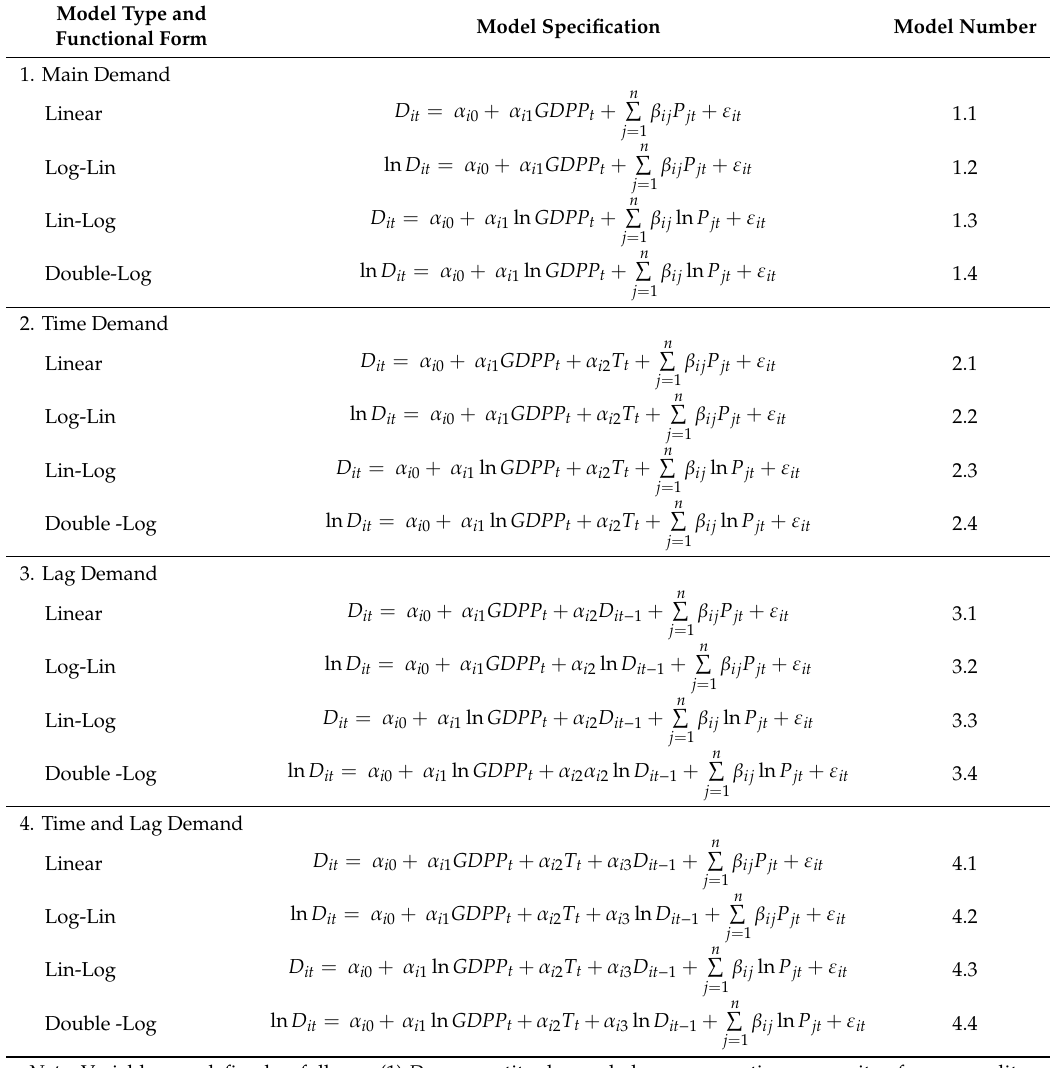
Table 1. Demand model